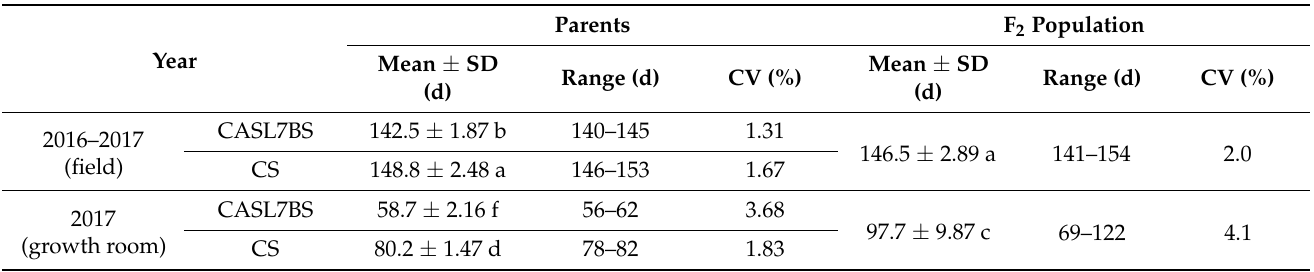
Table 2. Heading date of the F2 plants and their parents (CASL7BS and Chinese